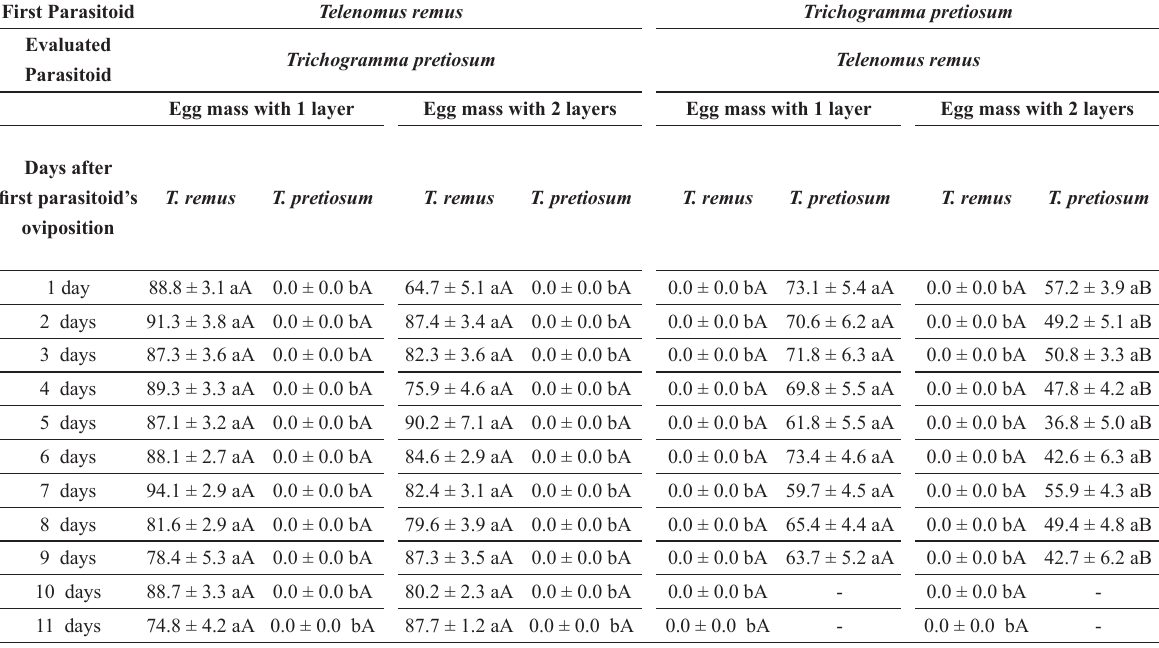
Mean number (± SEM) of Telenomus remus and Trichogramma pretiosum emerged from 1- or